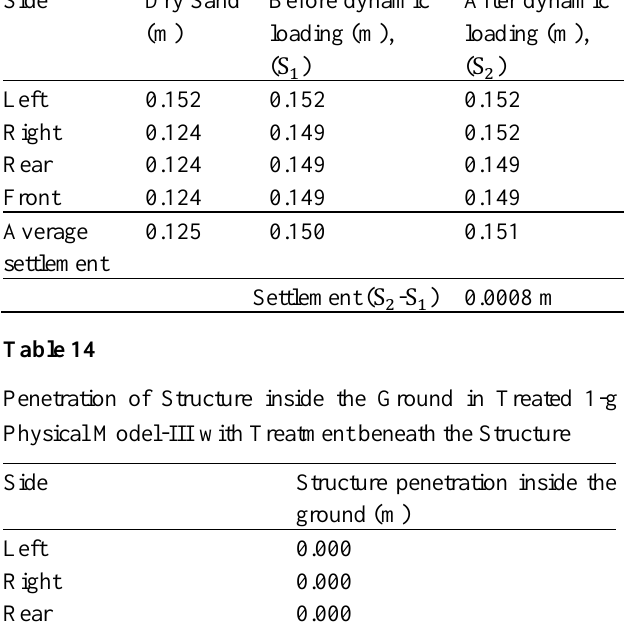
Fig. 14. Columns were un-damaged after